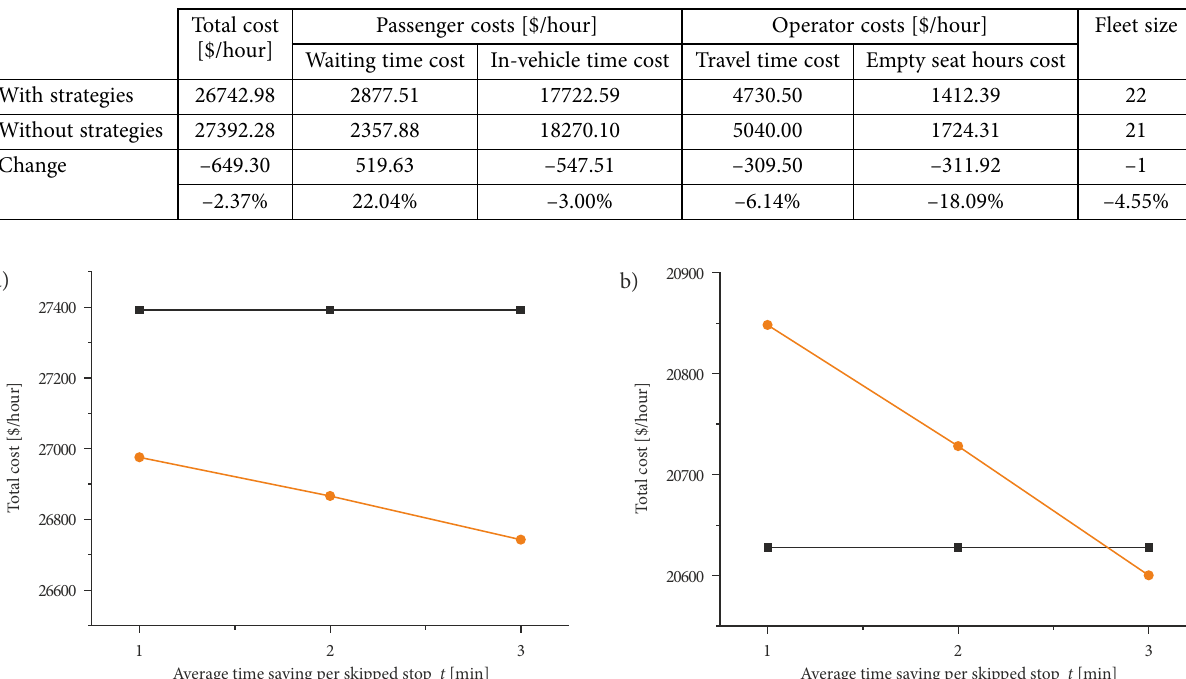
Table 5. Effects for passengers and operator introducing strategies